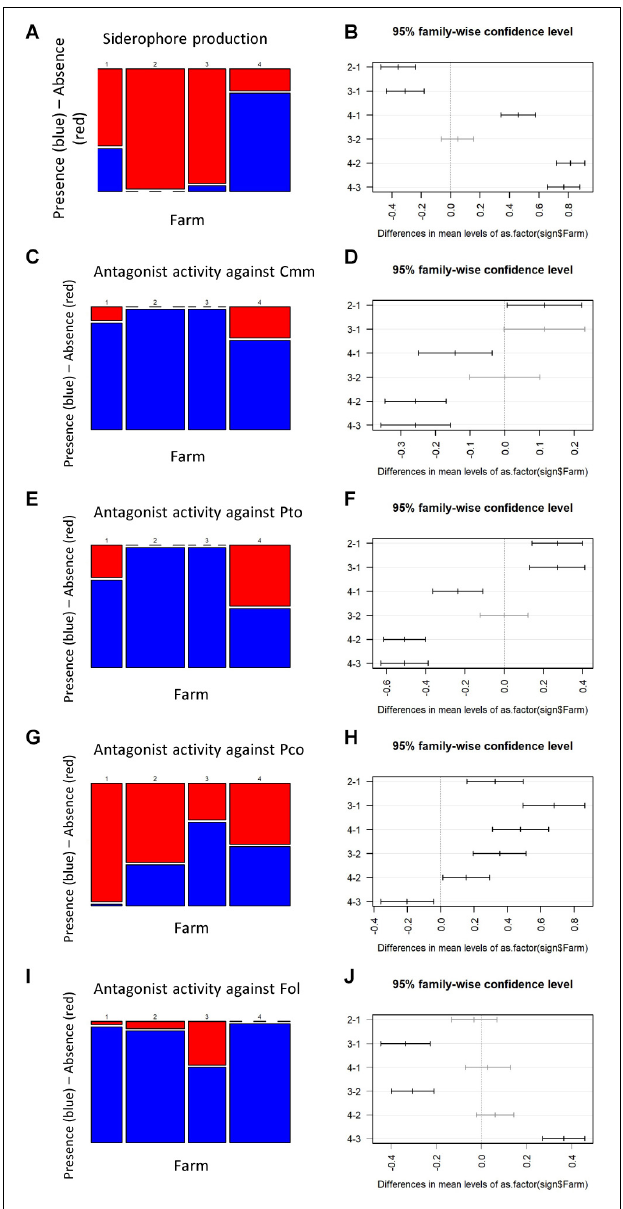
FIGURE 5 | Mosaic plot and Tukey plot of the traits showing the highest differentiation among farms (ANOVA test, p < 0.0001), namely, siderophore production (A) , antagonistic activity against Cmm (C) , Pto (E) , Pco (G) , and Fol (I) . Mosaic plots [left of the panels (B , D , F , H , J) ] show the relative frequency of the presence (blue) or absence (red) of a trait ( y -axis) given the farm ( x -axis); the width of the columns is proportional to the numerosity of the accessions isolated on each farm. On the right of the panels, the confidence intervals are shown of each pairwise comparison after the Tukey post hoc test. Pairwise comparisons that were not statistically different are shown in